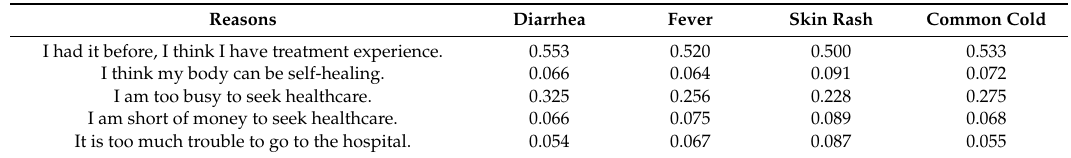
Table 2. Reasons for not seeking healthcare. Reasons Diarrhea Fever Skin Rash Common Cold